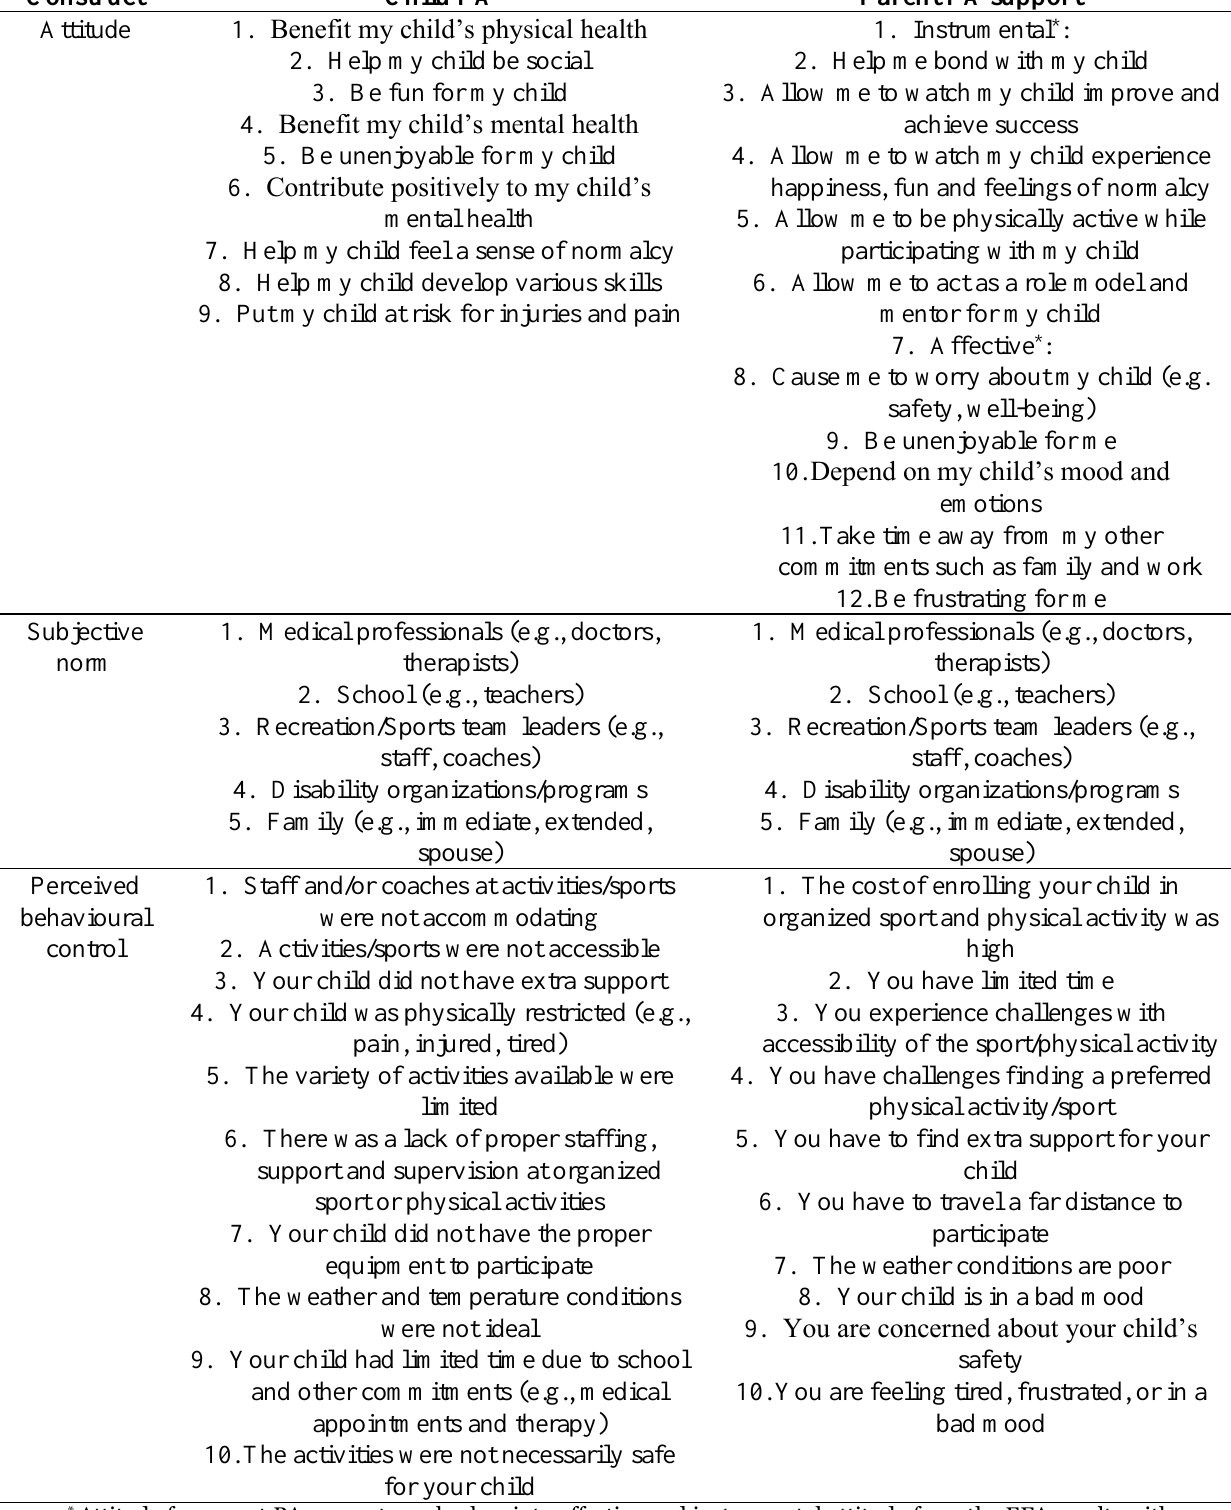
* Attitude for parent PA support was broken into affective and instrumental attitude from the EFA results